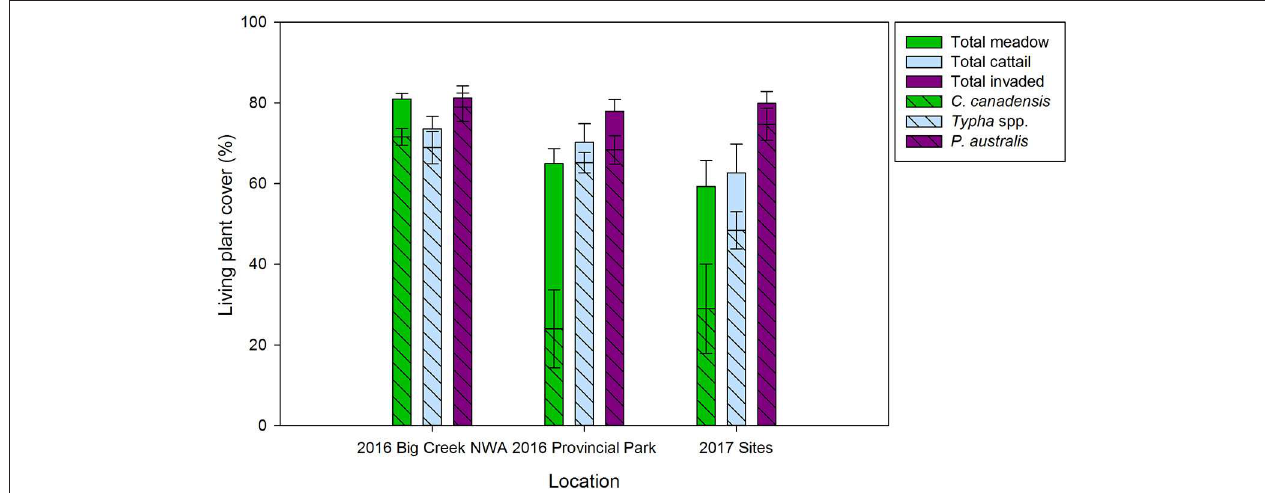
FIGURE 2 | Comparison of mean total living plant cover and mean cover of the dominant focal species ( C. canadensis , Typha spp., and P. australis , in meadow marsh, cattail marsh, and P. australis invaded marsh, respectively) in a higher nutrient (Big Creek) and lower nutrient (Long Point) environment. Bars from July 2016 average across five sites per nutrient environment, whereas sampling in 2017 in the Long Point Provincial Park covered a common gradient in water depth between resident communities [meadow ( n = 5) and cattail ( n = 5)] and P. australis invaded marsh ( n = 10). Standard error bars